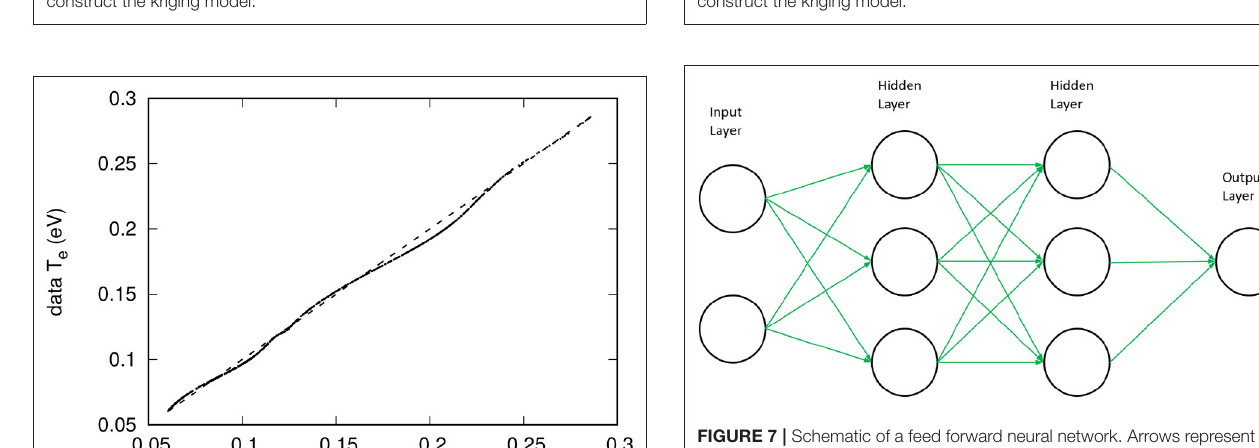
FIGURE 4 | Color plot of relative errors in model-inferred densities in a validation data set consisting of approximately 5,000 randomly selected points. Circles show the positions of the five directly optimized pivots used to construct the kriging model.